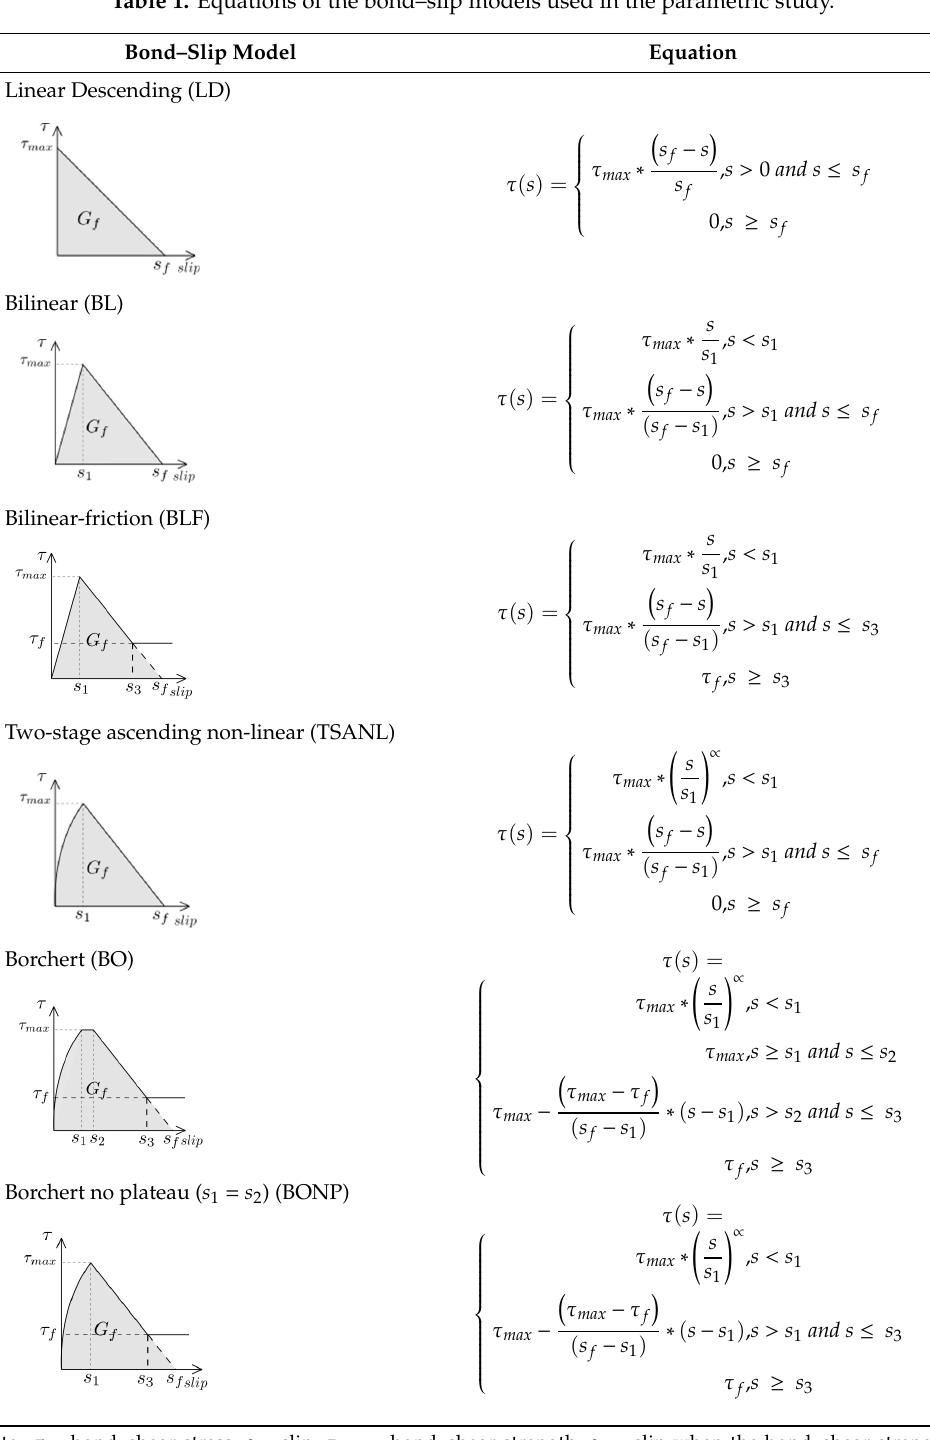
Table 1. Equations of the bond–slip models used in the parametric